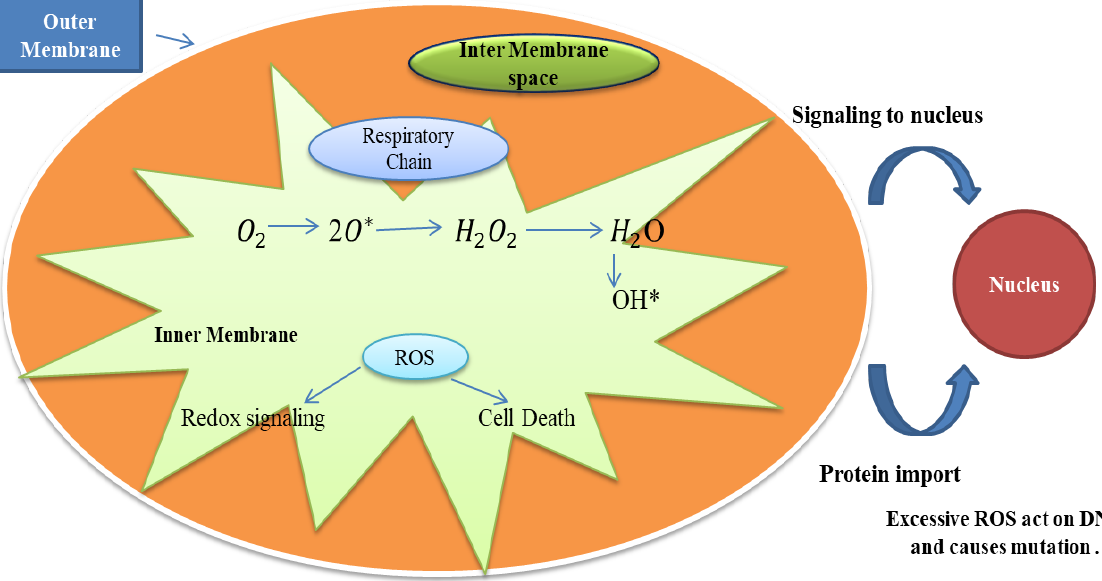
Figure 1. Schematic of the reaction of plasma-generated reactive species with V. cholera and the DNA distortion